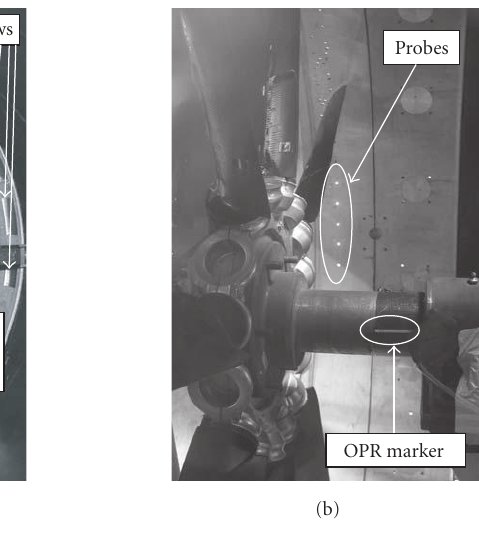
Figure 3: Internal views of BTT rig. Table 1: Comparison of glass reinforced nylon blade natural frequencies from impact hammer test experiments and FE model